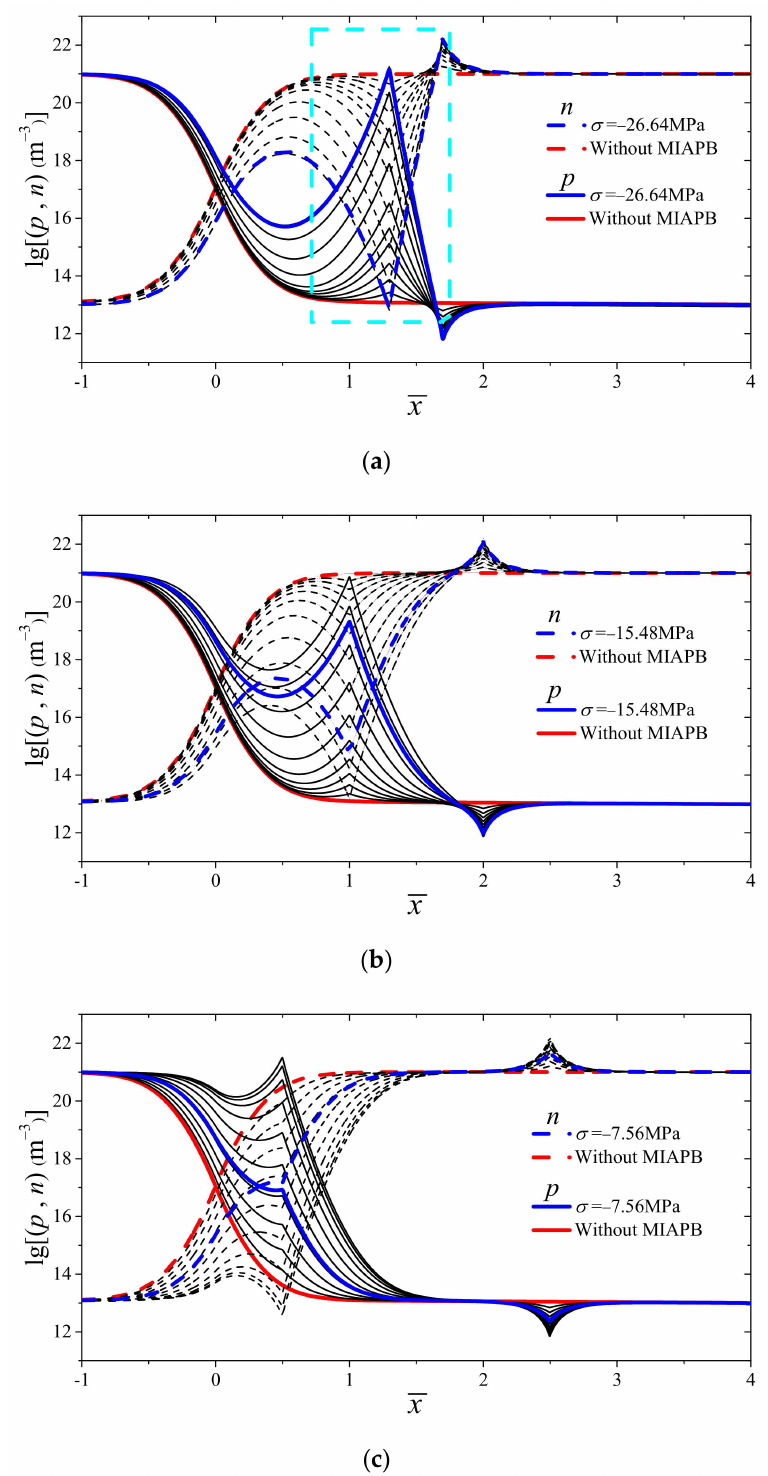
Figure 6. Changes in the carrier concentration when σ varies from 0 to 18 MPa (the left end of MIAPB is kept fixed, and the barrier width is varied). ( a ) ∆ l = 0.2 l 0 ; ( b ) ∆ l = 0.5 l 0 ; ( c ) ∆ l = 1.0 l 0